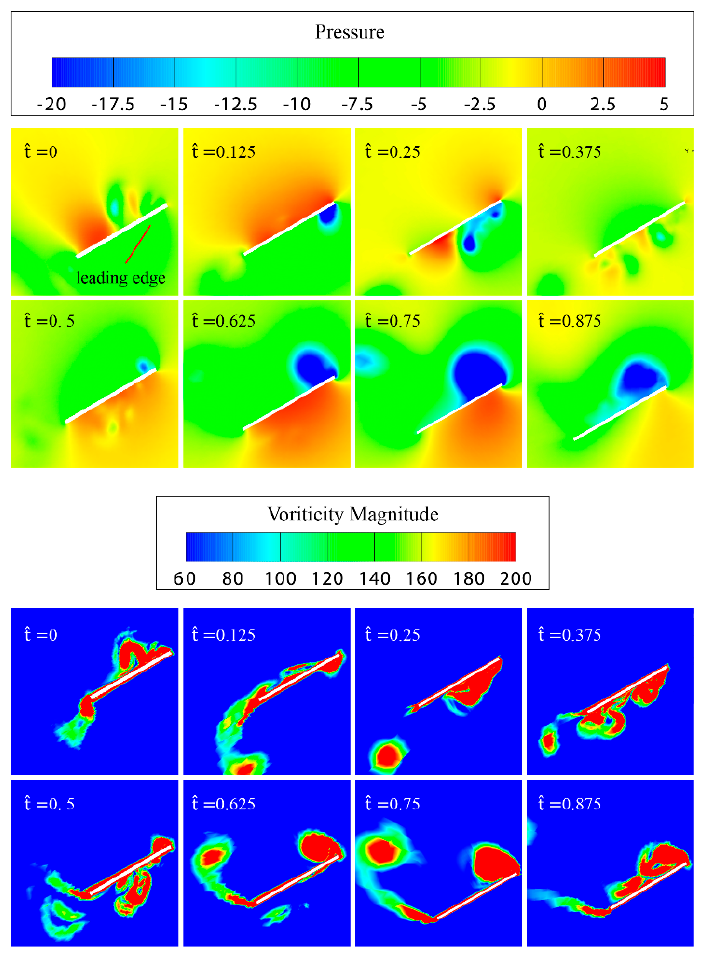
Figure 15. Variation of the flow pressure and vorticity during one flapping cycle in case 1.